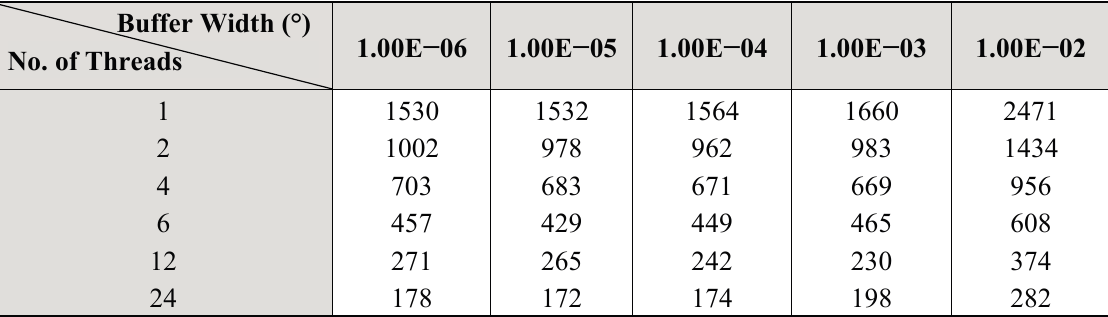
Table 2. Time of SDDG-BUFFER with different computing threads and buffer widths: (s).